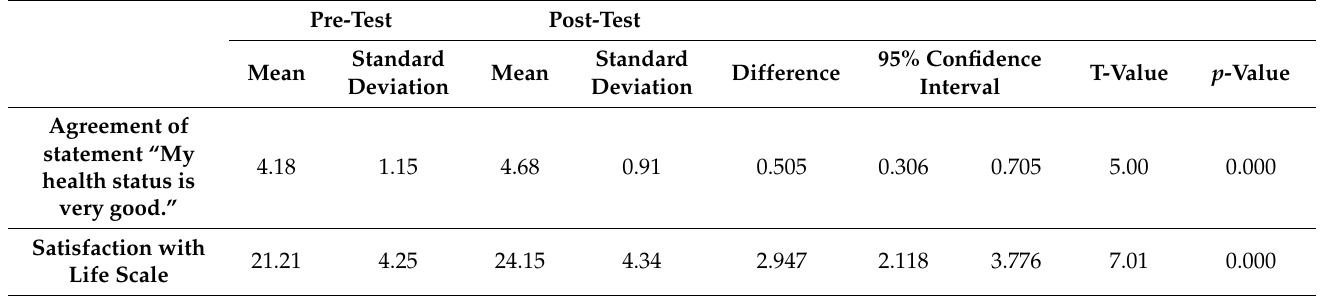
Table 4. t -test result of the agreement with the statement “my health status is very good” and satisfaction with life scale.